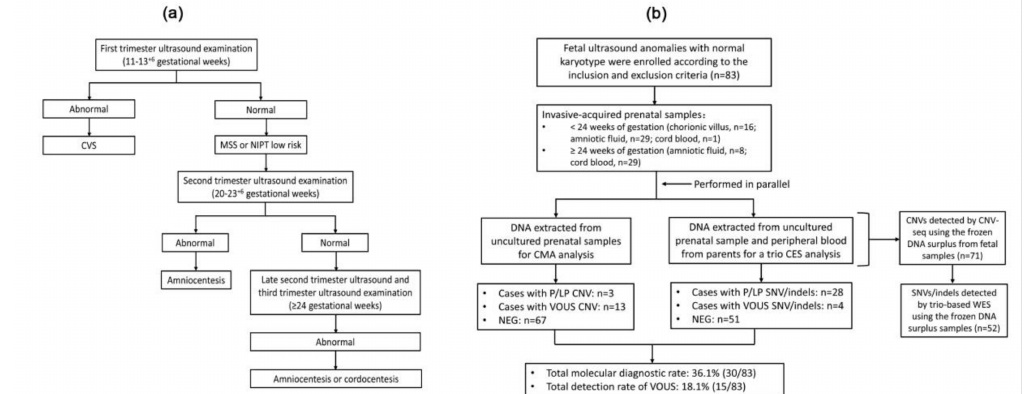
Figure 1. Workflow of the ultrasound examination and prenatal genetic diagnosis. ( a ) The workflow of routine ultrasound examination during pregnancy. CVS, chorionic villus sampling; MSS, maternal serum screening; NIPT, non-invasive prenatal testing. ( b ) CMA and CES were used for the simultaneous detection of CNVs and SNVs / indels. CMA, chromosomal microarray analysis; CES, clinical exome sequencing; P / LP, pathogenic / likely pathogenic; VOUS, variants of uncertain